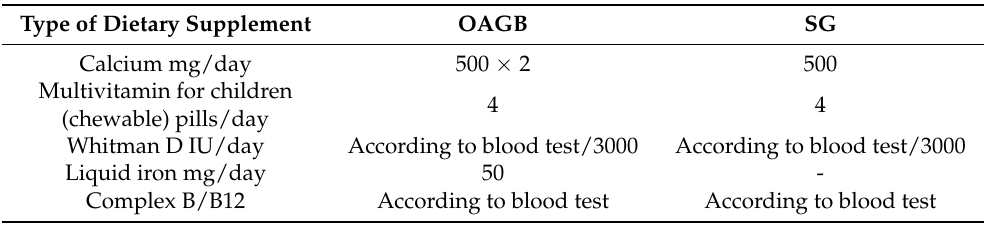
Table 1. Clinical guidelines for dietary supplements after bariatric surgery at Hadassah Hospital on Mount